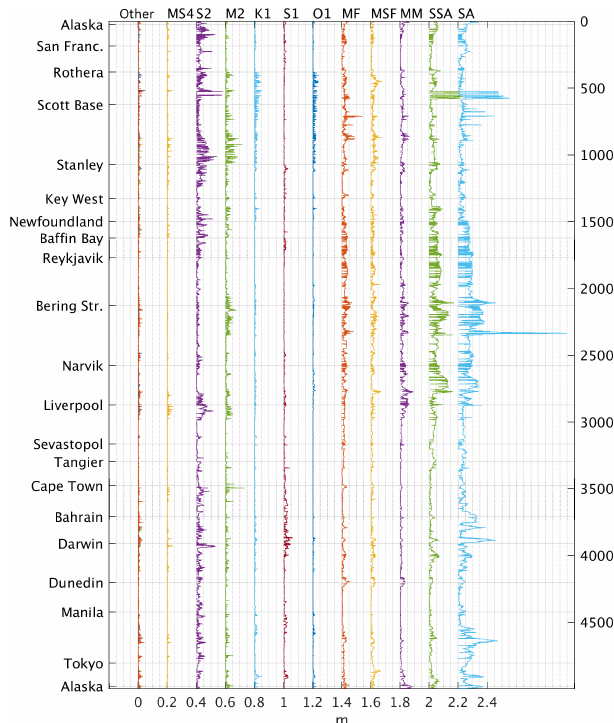
Figure 4. Vector difference (m, offset) between coefficients fitted to GTSM tide-and-surge ( M s ) or tide-only ( M t ) model. This is the breakdown into constituents of the difference between the panels of Fig. 1. The maximum effects for these harmonics and others are given in Table B1. See Fig. 1 and Appendix A for an explanation of coastal